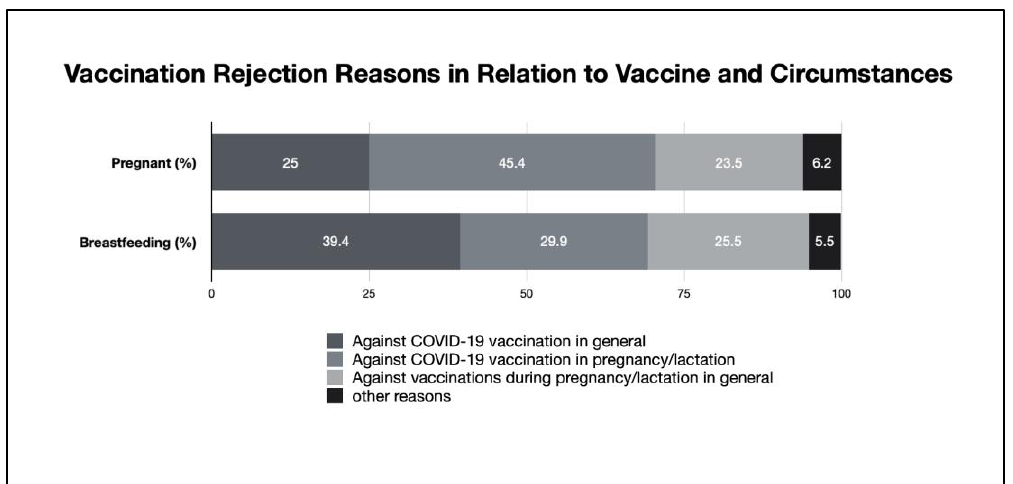
Figure 7. Vaccination rejection in relation to vaccine and circumstances.